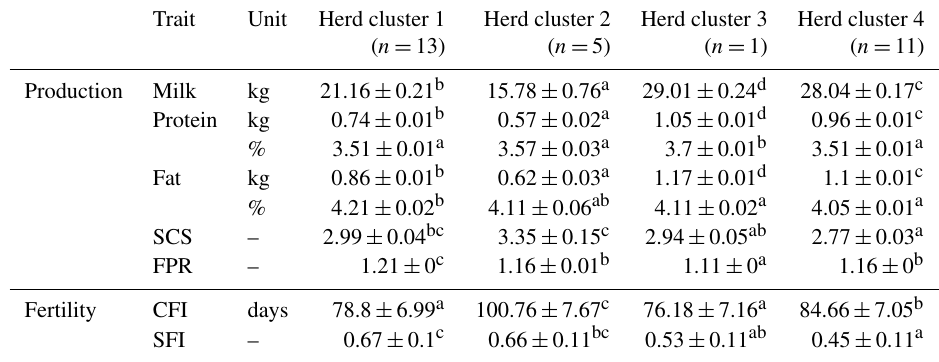
Table 3. Least square means and corresponding standard errors of test day and fertility traits in the first three lactations for four herd clusters created with CoVAHC.